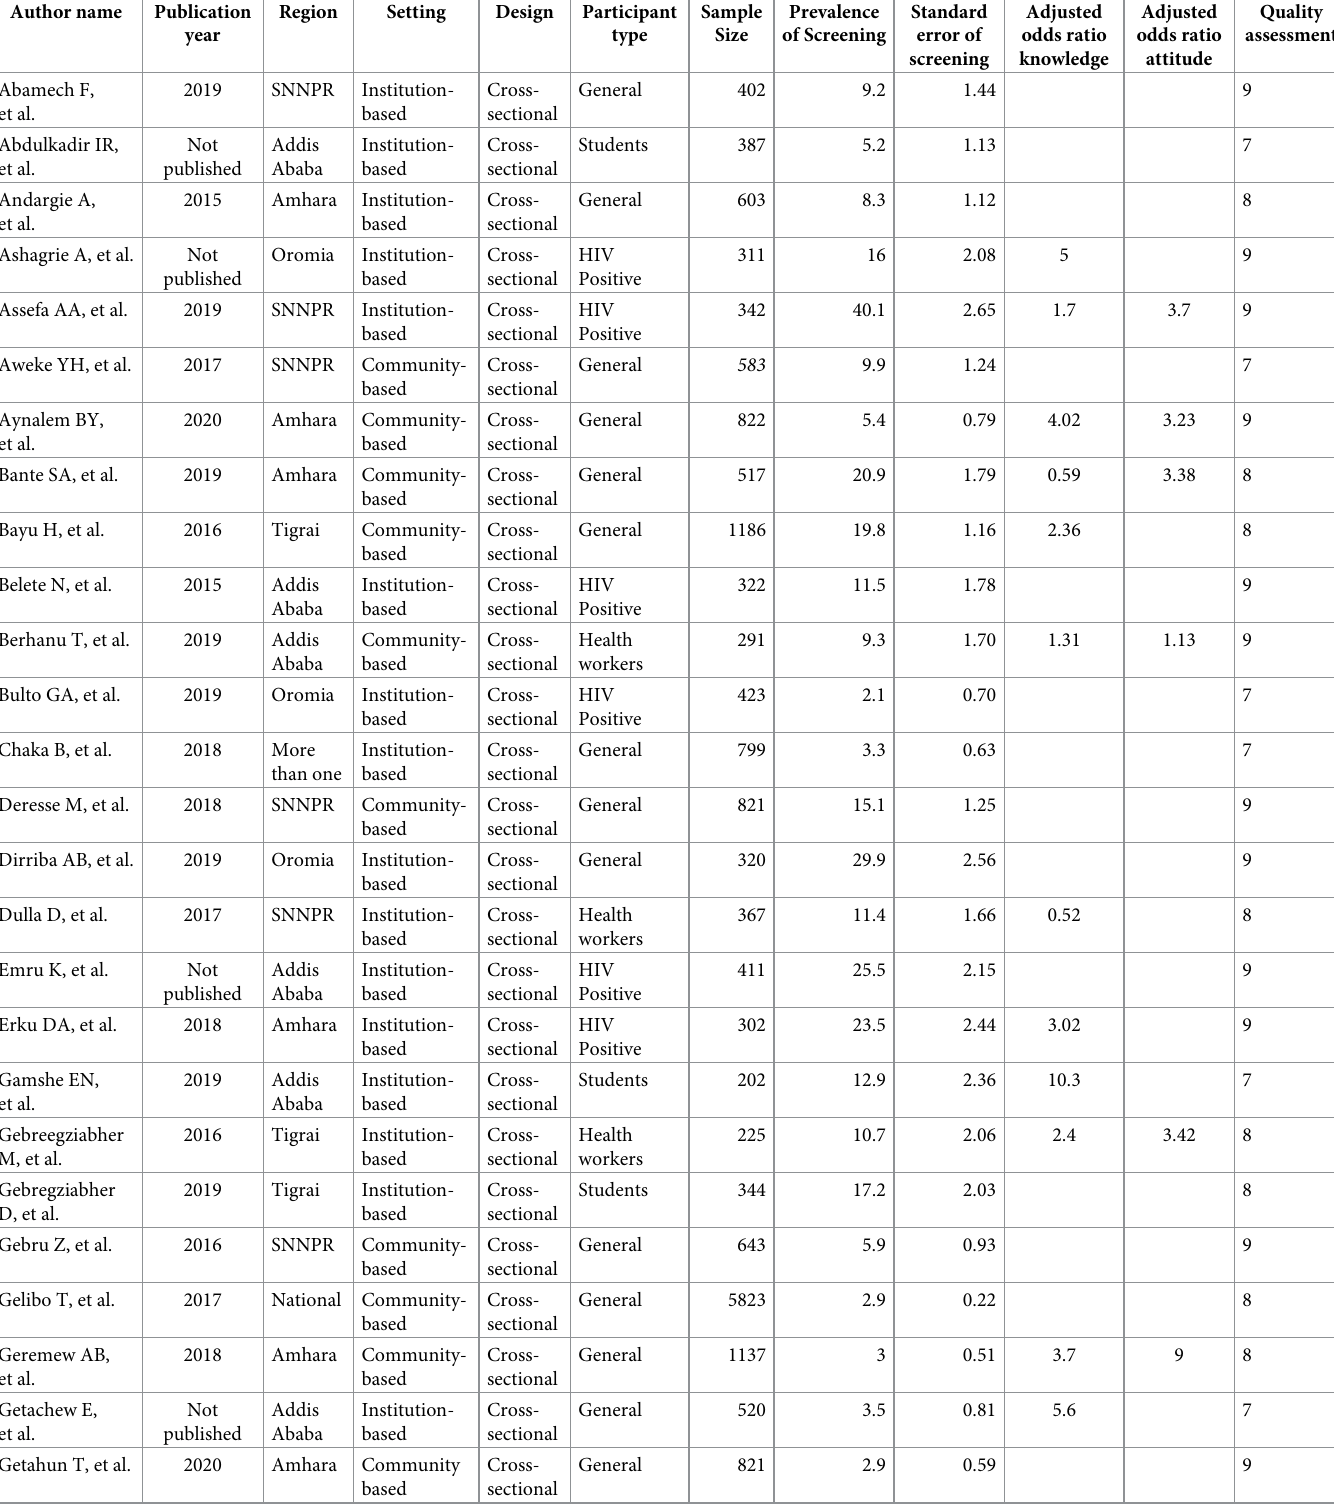
Table 1. Baseline characteristics of included studies to analyze the impact of knowledge and attitude on the utilization rate of cervical cancer screening tests in